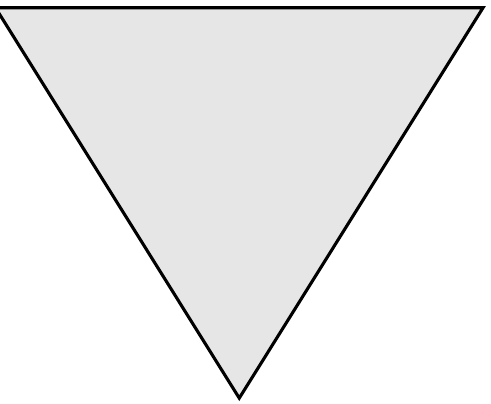
Figure 4. The upside-down social pyramid of the constitutional state.